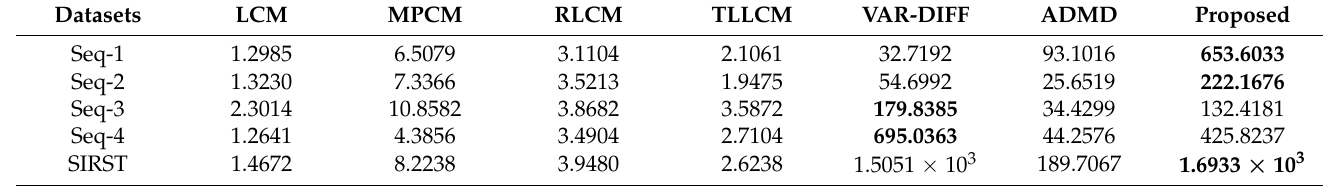
Figure 4. Processing results of different algorithms. ( a ) Original image, ( b ) LCM, ( c ) MPCM, ( d ) TLLCM, ( e ) RLCM, ( f ) ADMD, ( g ) VAR-DIFF, and ( h ) proposed method. Note that the gray values of all images are normalized to the [0–255] interval.